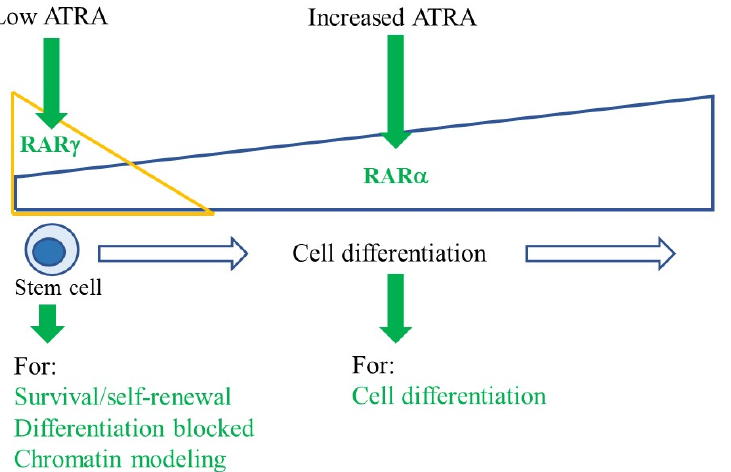
Figure 2. Active RAR γ and RAR α control stem cell maintenance and differentiation, respectively RAR γ expression is restricted to stem cells and their immediate offspring, and as these cells differ ‐ entiate, a fall in the expression of RAR γ is mirrored by an increase in the expression of RAR α . RAR γ functions to maintain stem cells when ATRA is absent or low. ATRA activation of RAR α promotes cell differentiation.